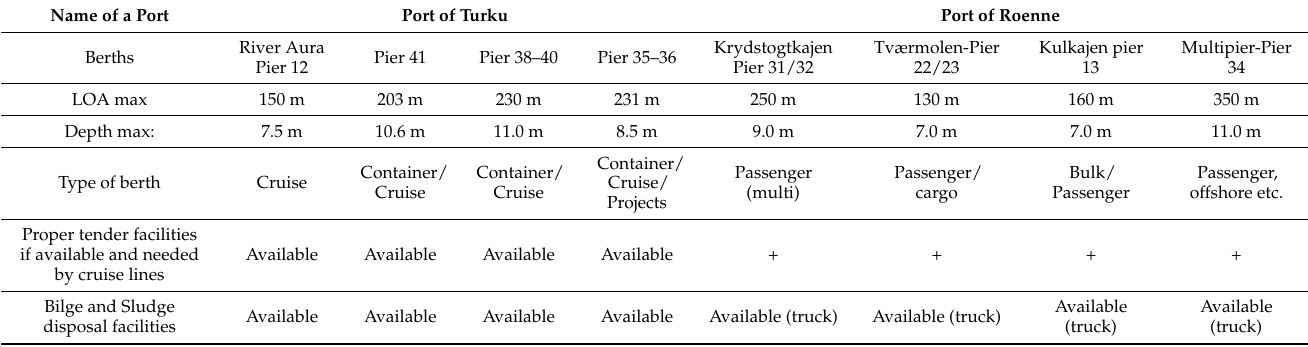
Table 2. Basic data on quays dedicated to cruise ships in selected ports in the Baltic